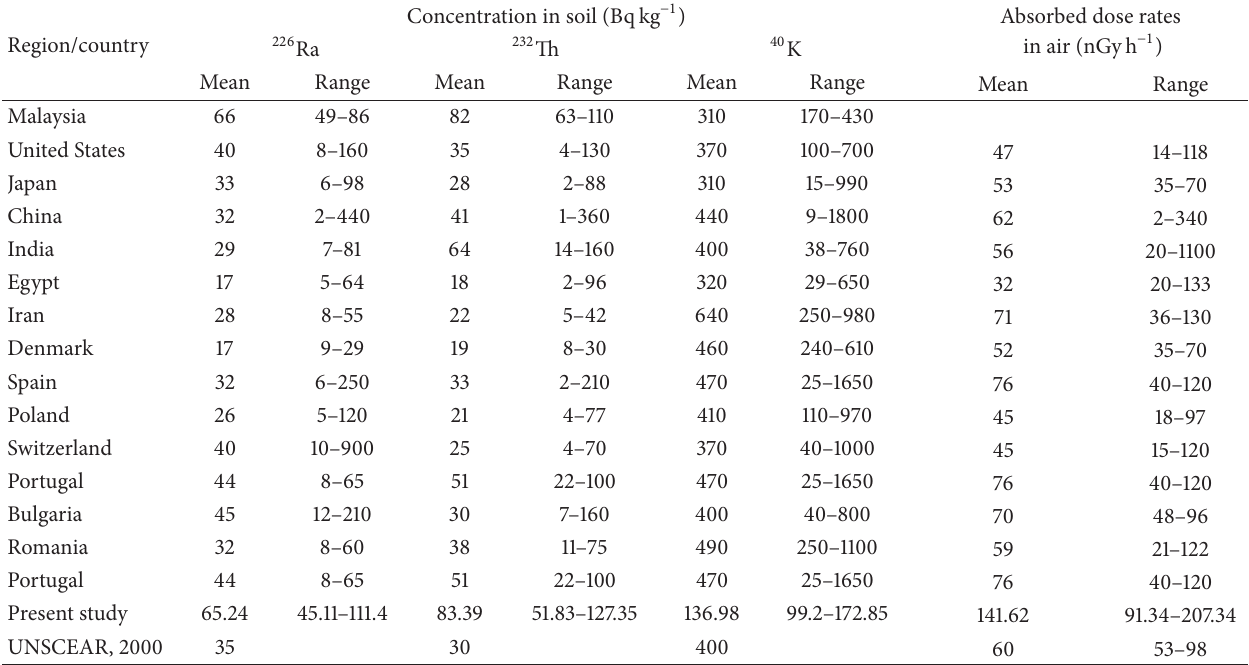
and established by UNSCEAR